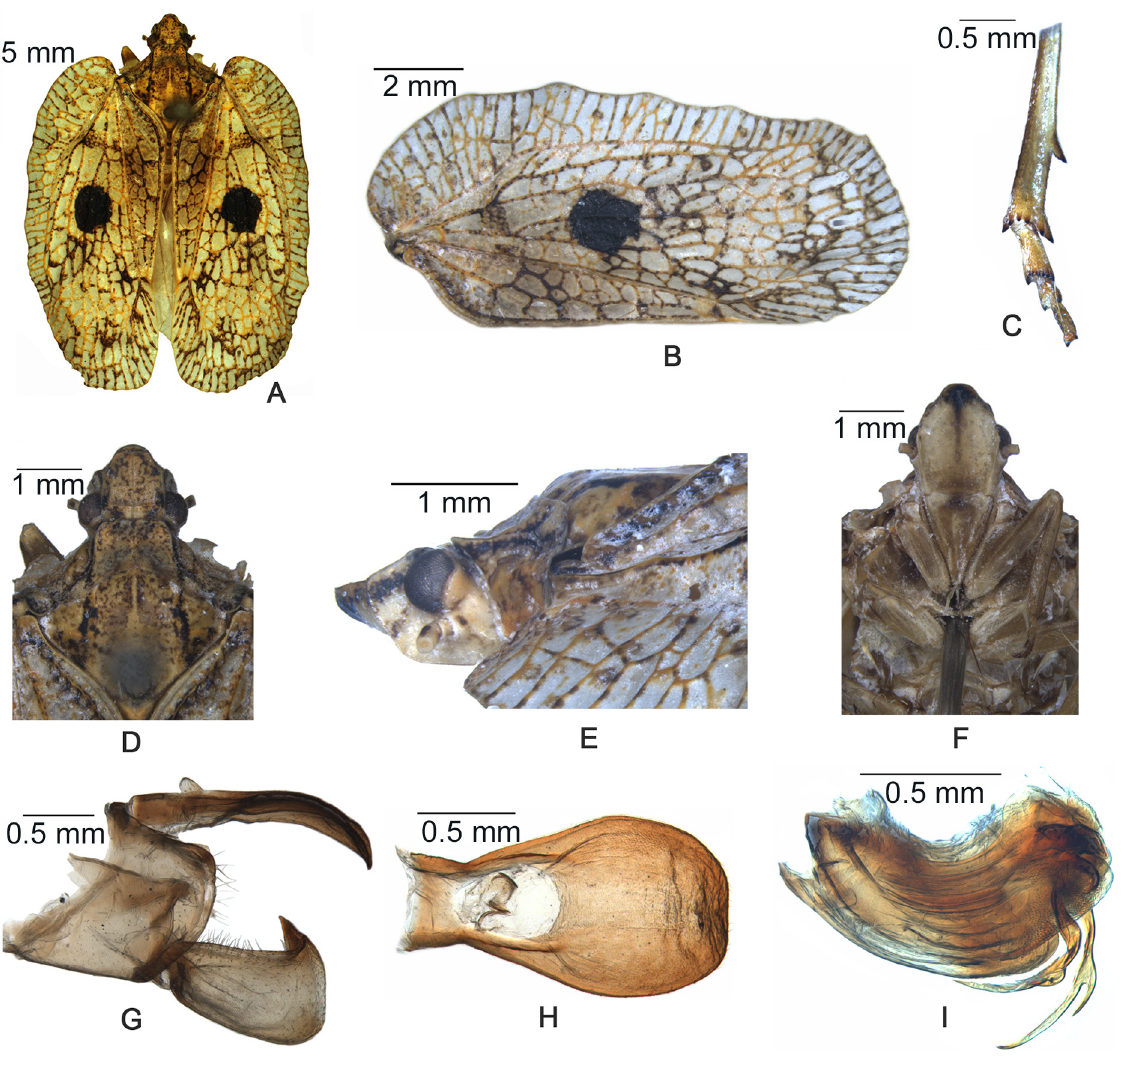
Fig. 1. Atracis ocularia sp. nov., holotype, ♂ (NWAFU). A . Habitus, dorsal view. B . Tegmen. C . Hind leg apex. D . Head and thorax, dorsal view. E . Head and thorax, left lateral view. F . Face. G . Male genitalia (phallic complex removed), right lateral view. H . Male anal tube, dorsal view. I . Phallic complex, right lateral